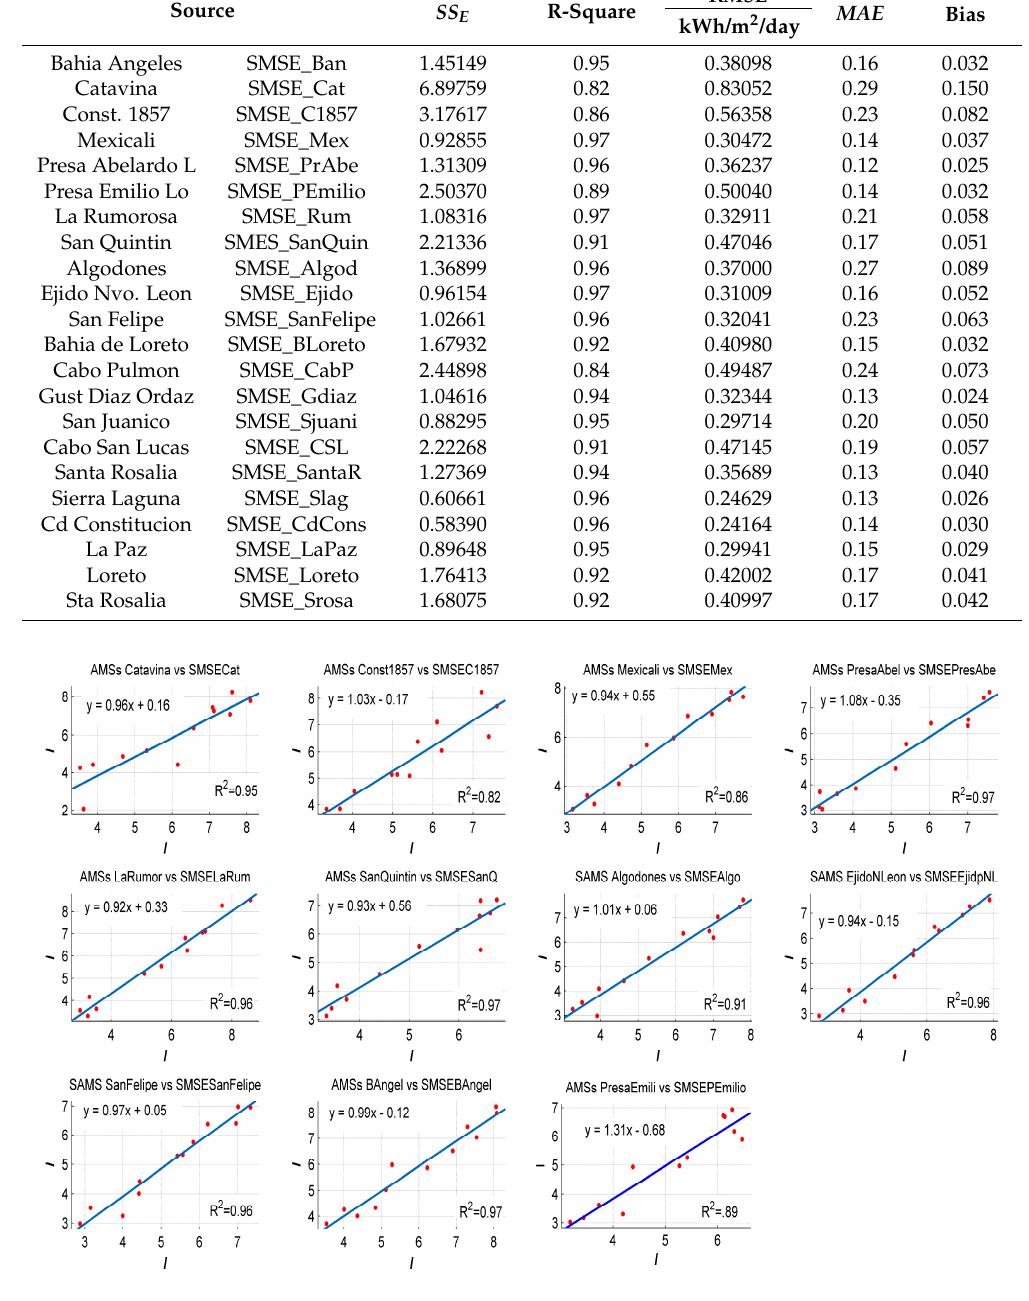
Figure 6. Monthly satellite vs measured data for meteorological stations in Baja California Sur. As we can see in Figure 5, linear fitting allows us to determine if we could use SMSE data for the assessment. The highest R-square value is 0.97 for AMSs PresaAbel, SanQuintin and BAngel, while the lowest R-square value is 0.82 corresponding to AMSs Const 1857. It is important to mention that SMSE data were extracted at the same geographic postion as the AMSs and SAMSs. In Baja California Sur, linear regression between AMSs and SAMSs versus SMSE data demonstrated that SMSE could be used to assess solar energy. In Figure 6, the highest value of R-square is 0.96 corresponding to SAMS CdConst and the lowest R-square 0.84 corresponds to AMS BahiaLore.